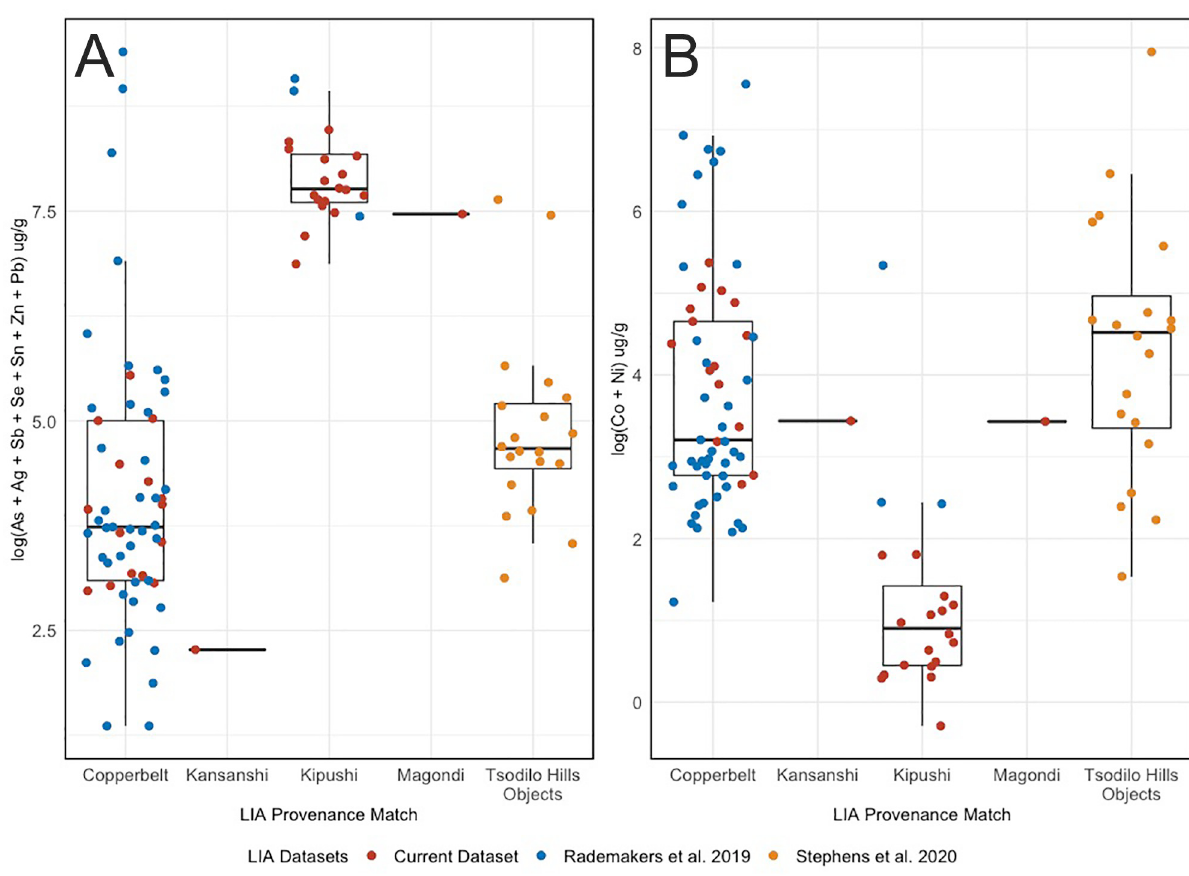
Fig 10. Chemistry Boxplots. Logged concentrations of chalcophile (A) and siderophile (B) elements from samples in this paper, Rademakers et al. [24], and Stephens et al. [33]. Ingots are grouped by their determined isotopic provenance, and the experimental “X” ingot is represented by the “Kansanshi” category since we know its specific